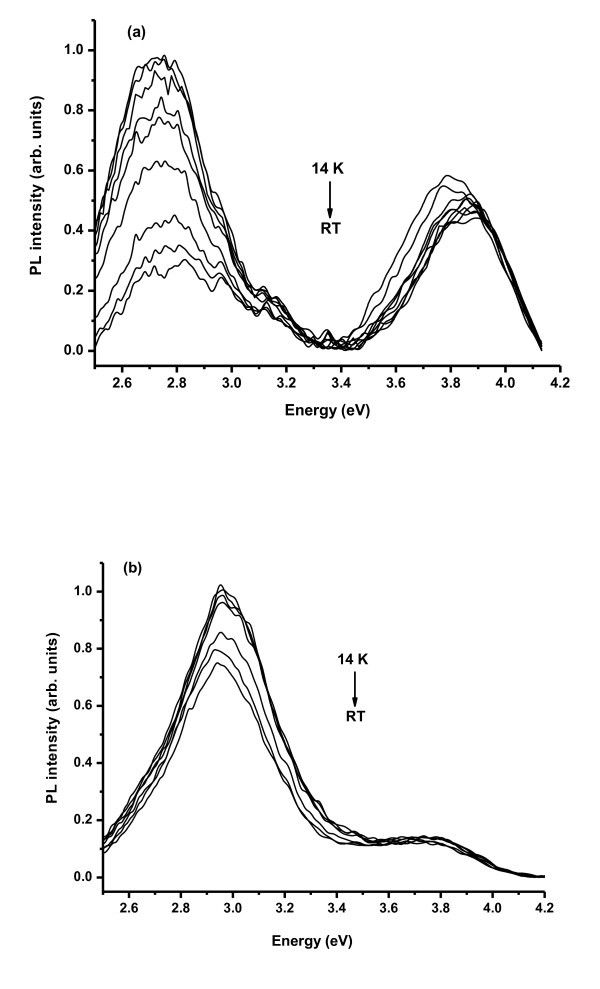
Temperature-dependent PL spectra: for sample (a) #987 implanted with 1 × 1015 atoms.cm-2 and annealed at 1100°C and (b) #989 implanted with 1 × 1013 atoms.cm-2 and annealed at 1000°C obtained with 4.7 eV excitation.